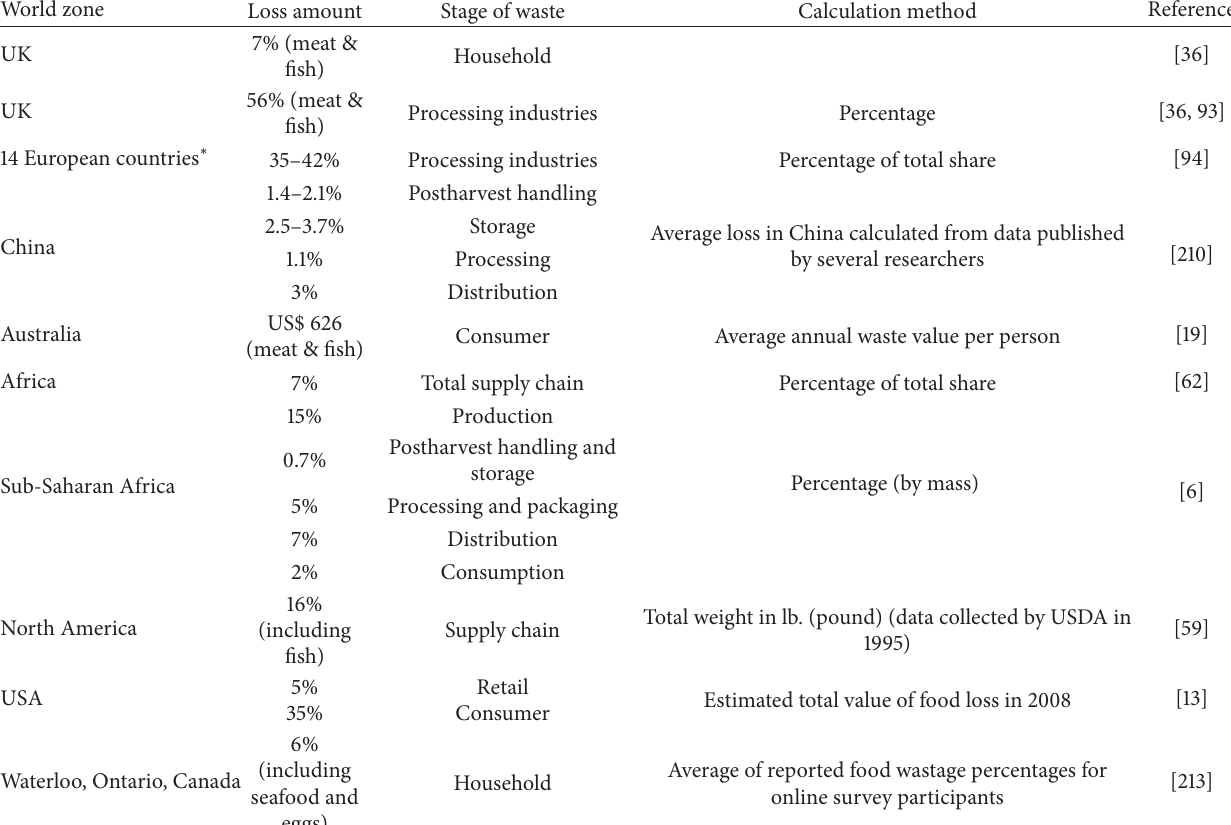
Table 6: Amount/percent/value of meat and poultry waste in the world food supply